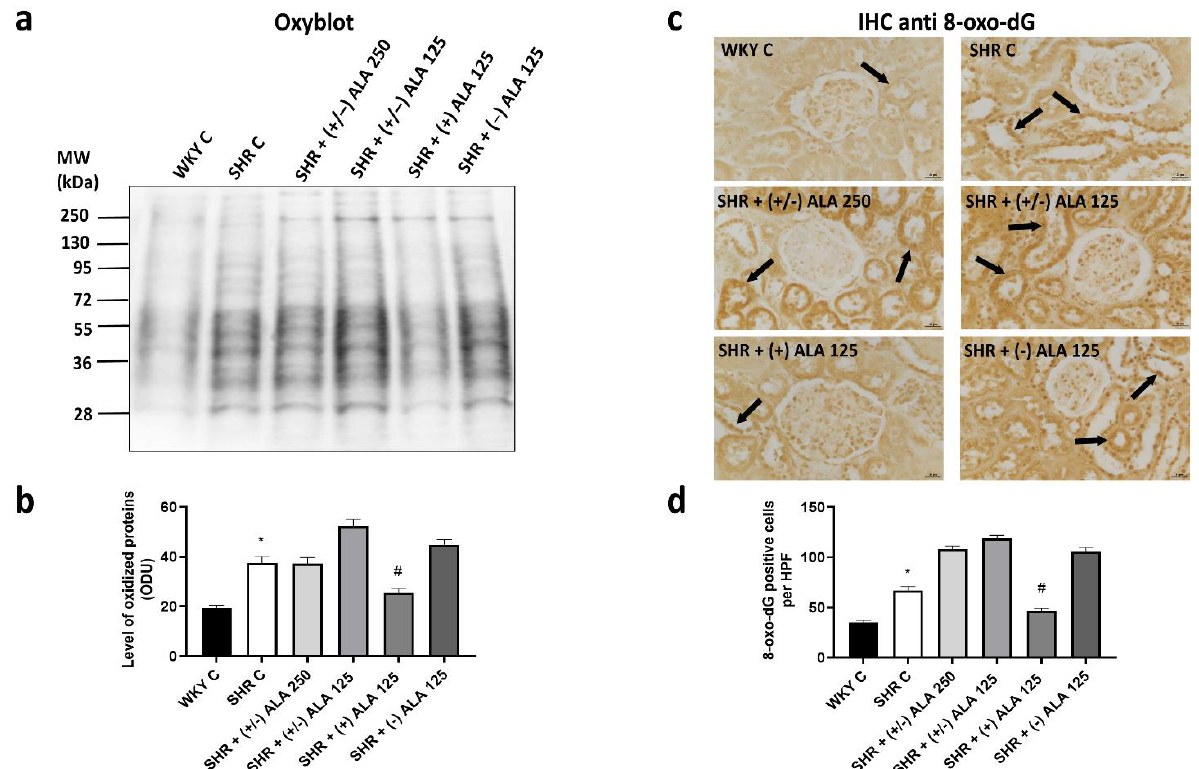
Figure 1. Oxidative stress in the kidney. ( a ) Lysates of kidney from WKY C, SHR C, SHR (+/ − )-alpha-lipoic acid (ALA) 250 µmol/kg/day, SHR + (+/ − ) ALA 125 µmol/kg/day, SHR + (+) ALA 125 µmol/kg/day, SHR + ( − ) ALA 125 µmol/kg/day were immunoblotted using the Oxyblot kit; ( b ) The bar graph reports the level of oxidized proteins measured in optical density unit (ODU); ( c ) Sections of kidney processed for the 8-oxo-dG immunohistochemistry (IHC). Arrow: positive nucleus. Calibration bar 25 µm; ( d ) The bar graph shows the quantification of the number of positive cells per high-power field (HPF) (40×). Data are mean ± S.E.M. * p < 0.05 vs. WKY C; # p < 0.05 vs. SHR C.